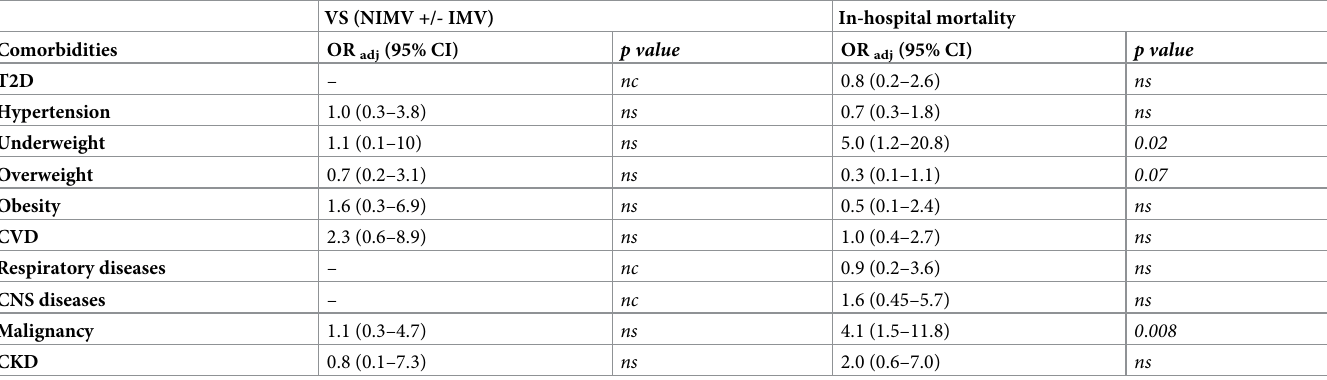
Abbreviations: CKD, chronic kidney disease ; CNS, central nervous system ; CVD, cardiovascular disease ; IMV, invasive mechanical ventilation ; nc, not calculable ; NIMV, non-invasive mechanical ventilation ; ns, not significant ; T2D, type 2 diabetes ; VS, ventilation support . OR adj , age- and gender-adjusted Odds Ratio; 95%CI , 95% Confidence Intervals